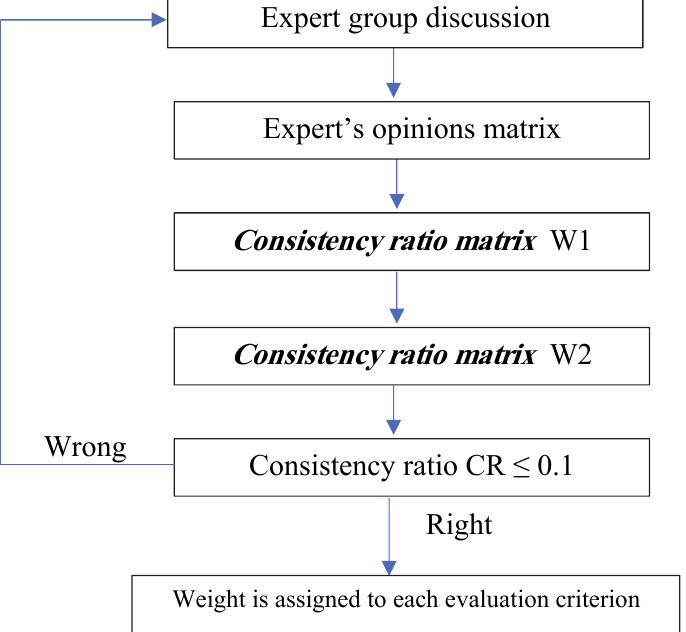
Fig. 2. Diagram of steps for determining the evaluation weights following AHP method (Source: Authors synthesize from research